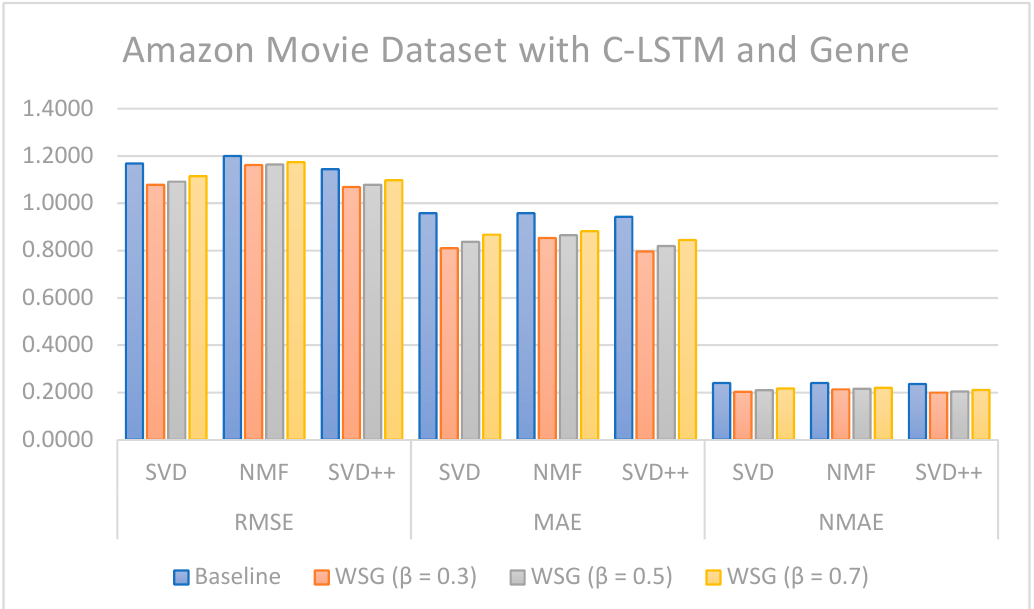
Figure 10. RMSE, MAE, and NMAE with and without L-CNN sentiment and genres-based model and different values of β on Amazon Movie dataset. Table 8. RMSE, MAE, and NMAE with and without C-LSTM sentiment and genres-based model and different values of β on Amazon Movie dataset.